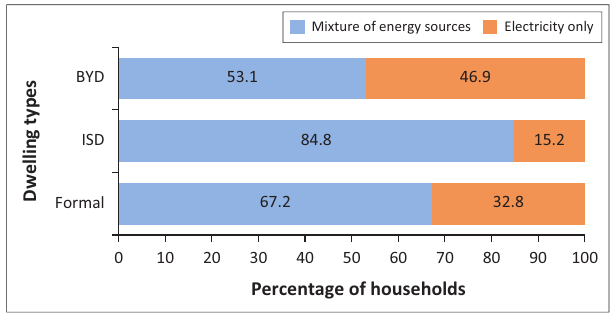
FIGURE 4: Proportion of households utilising a mixture of electrical and nonelectrical energy sources ( n = 530).